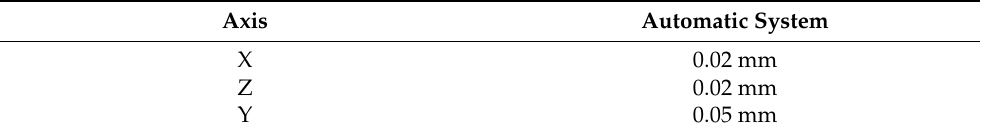
Table 8. Manufacturer’s axis accuracy specs.